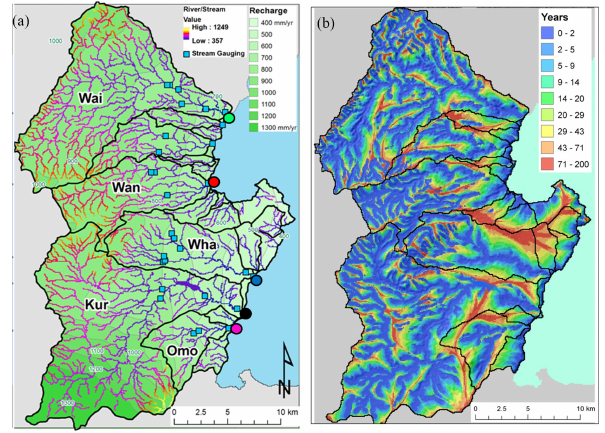
Figure 1. (a) MODFLOW model setup of the WLTC from Gusyev et al. (2013), and (b) the groundwater transit time map for river water of the WLTC produced with the MODPATH-MODFLOW model. The colour coding indicates groundwater age from 0yr (blue) up to 200yr old